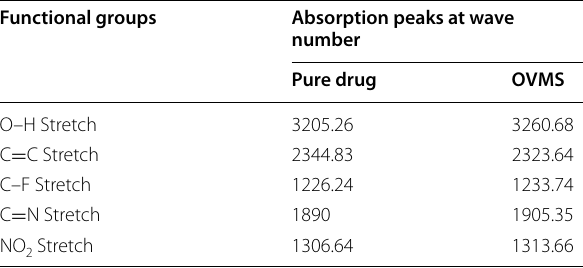
Table 6 Identification of functional groups present in VMS based on FTIR ranges